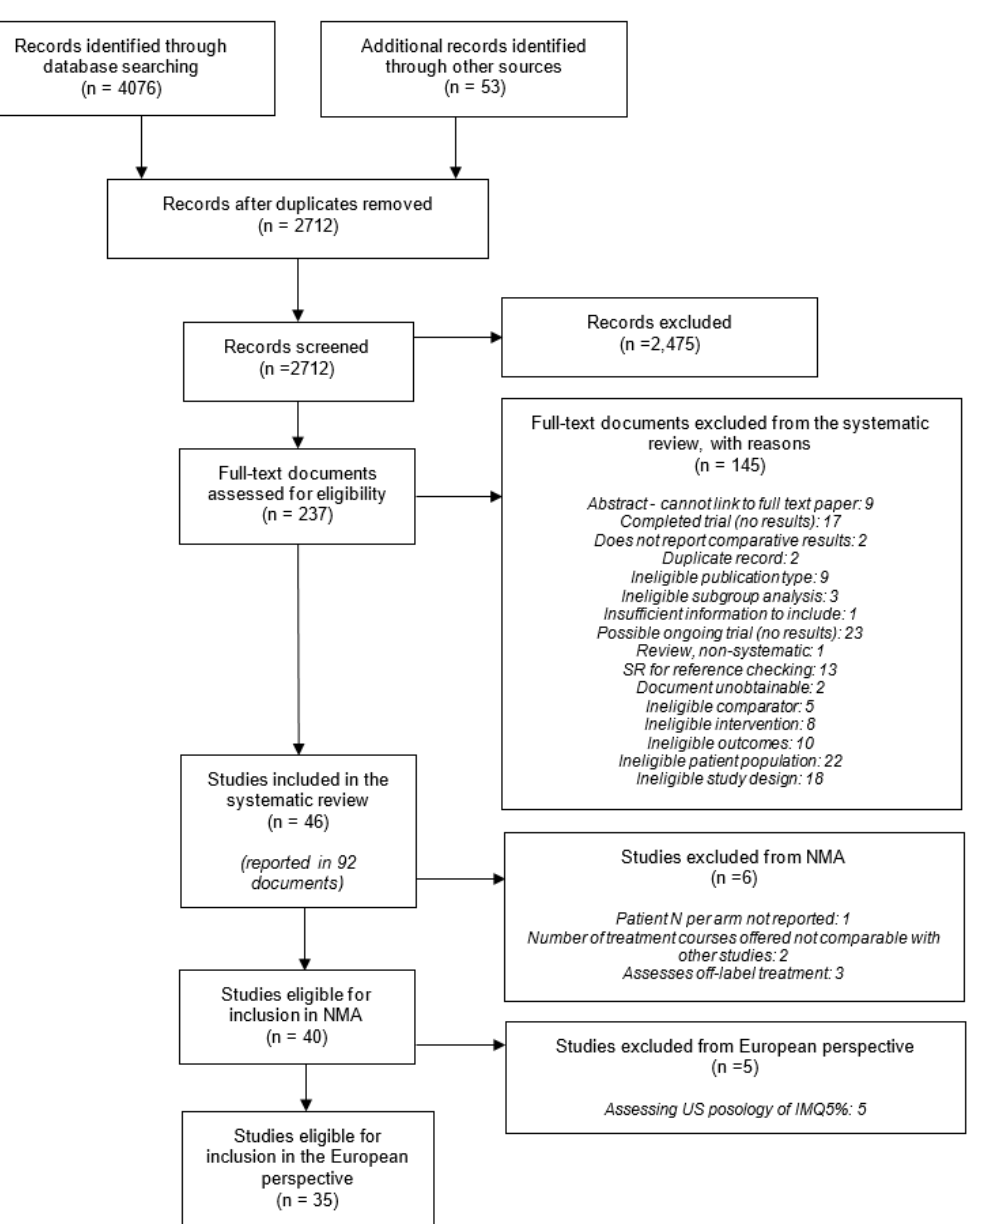
Figure 1. PRISMA Flow Diagram. Overall, four of the 46 studies (9%) were considered to have a low risk of bias [51–54], 26 (57%) had an unclear risk of bias [28,55–78], and 16 (35%) were considered to have serious methodological concerns [79–94]. A summary of the risk of bias assessment is shown in Figure